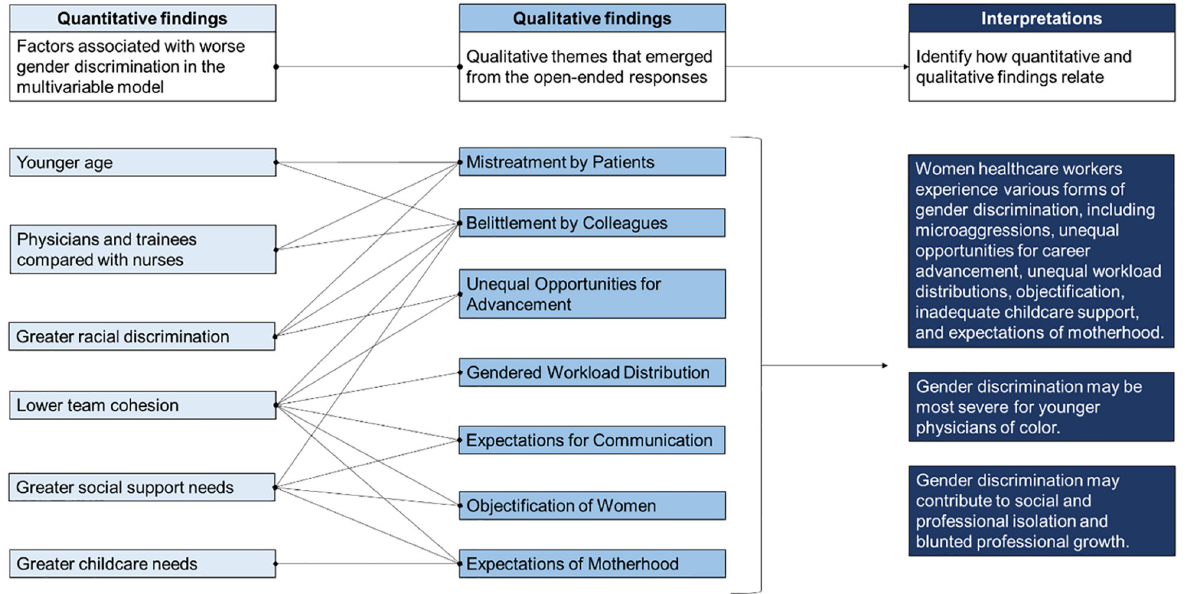
Fig 2. Merging of quantitative and qualitative